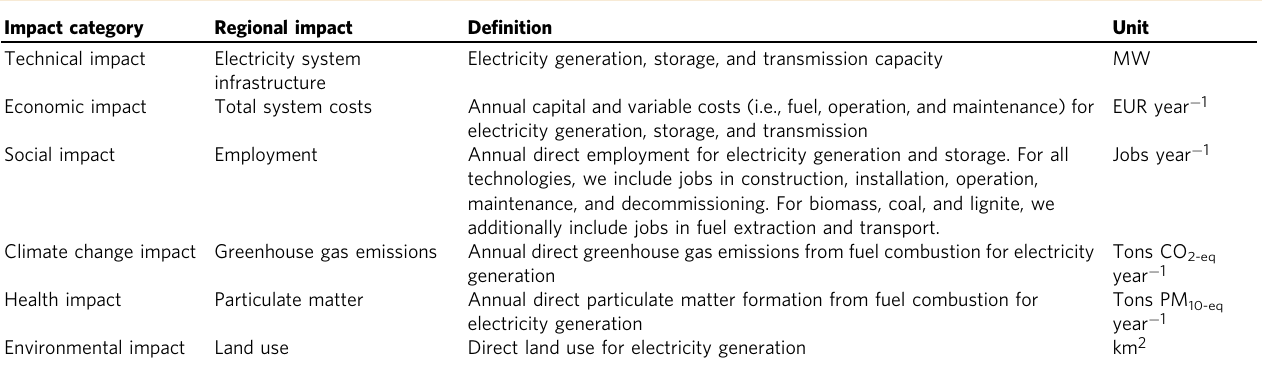
Table 2 De fi nition of regional impacts and